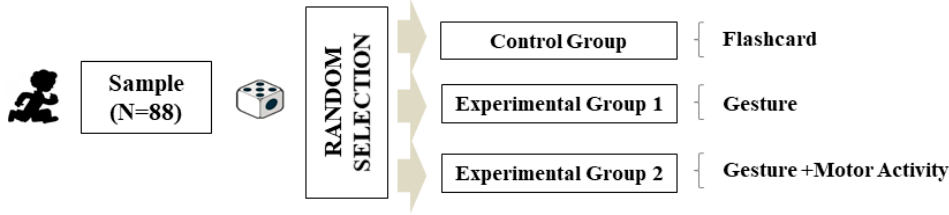
Figure 1. Sample and assignment of study groups.